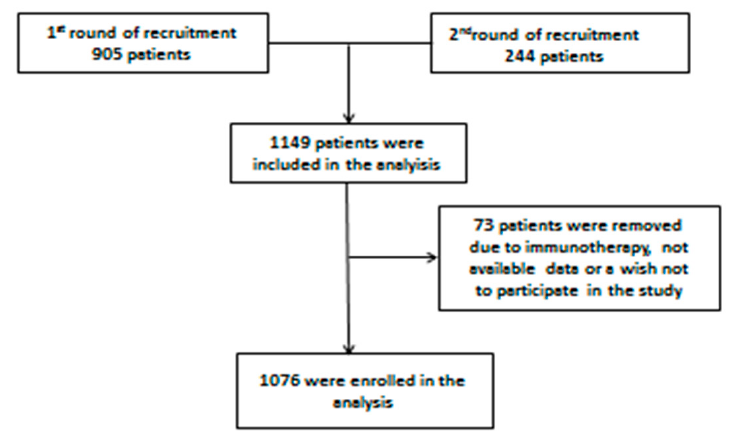
Figure 1. Flow chart for the final enrolment in the